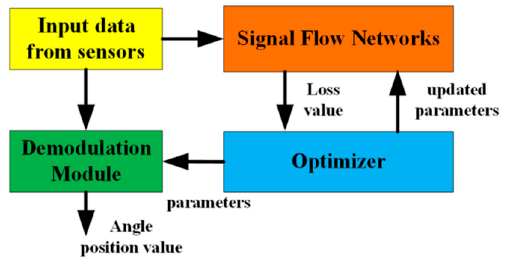
Figure 3. Block diagram of the proposed method.